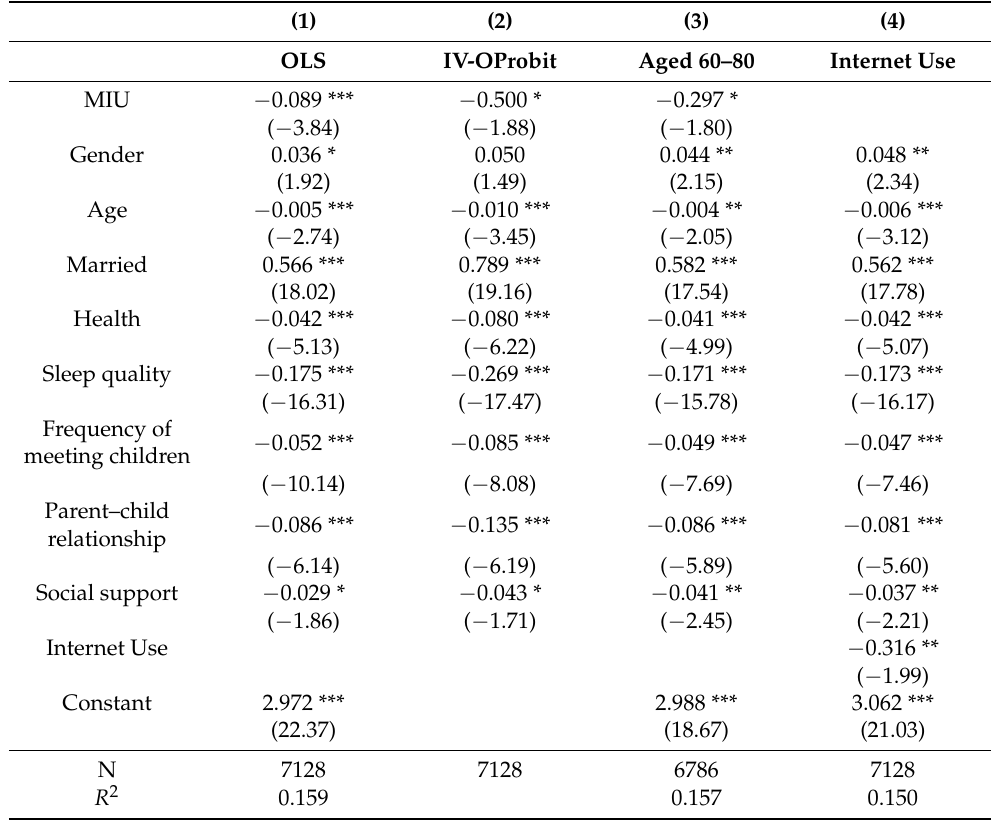
Table 5. Sensitivity